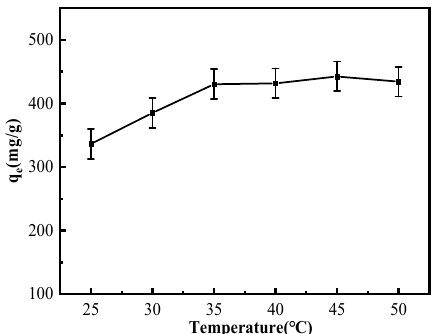
Figure 9. Effect of temperature adsorption.